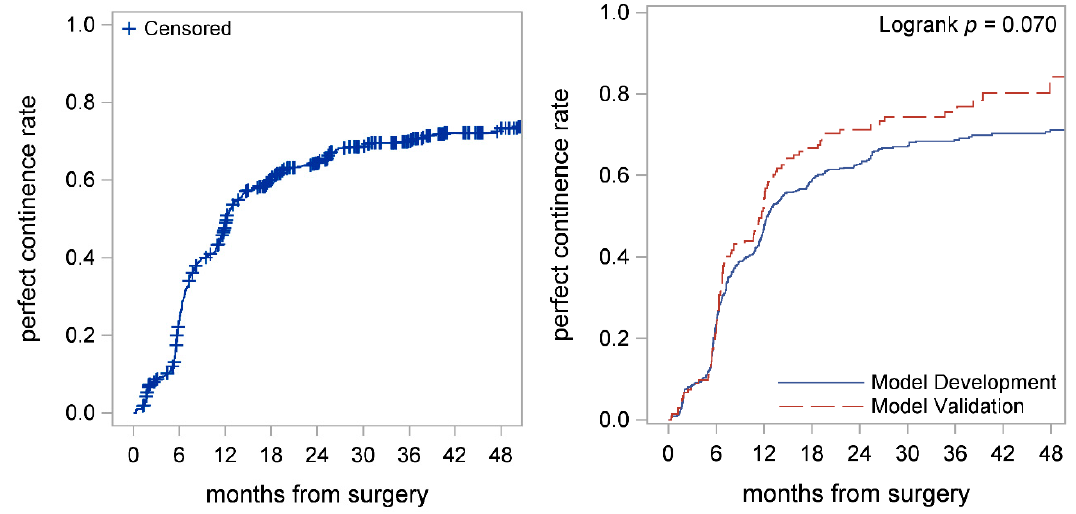
Figure 2. Kaplan–Meier curves showed time to perfect continence for the entire cohort ( left panel ) and time to perfect continence in model development and validation cohorts ( right panel ). Median time to perfect continence was 12.1 (95% CI: 11.7–13.1) months. Perfect continence rates in model development and validation cohorts were similar ( p = 0.07).